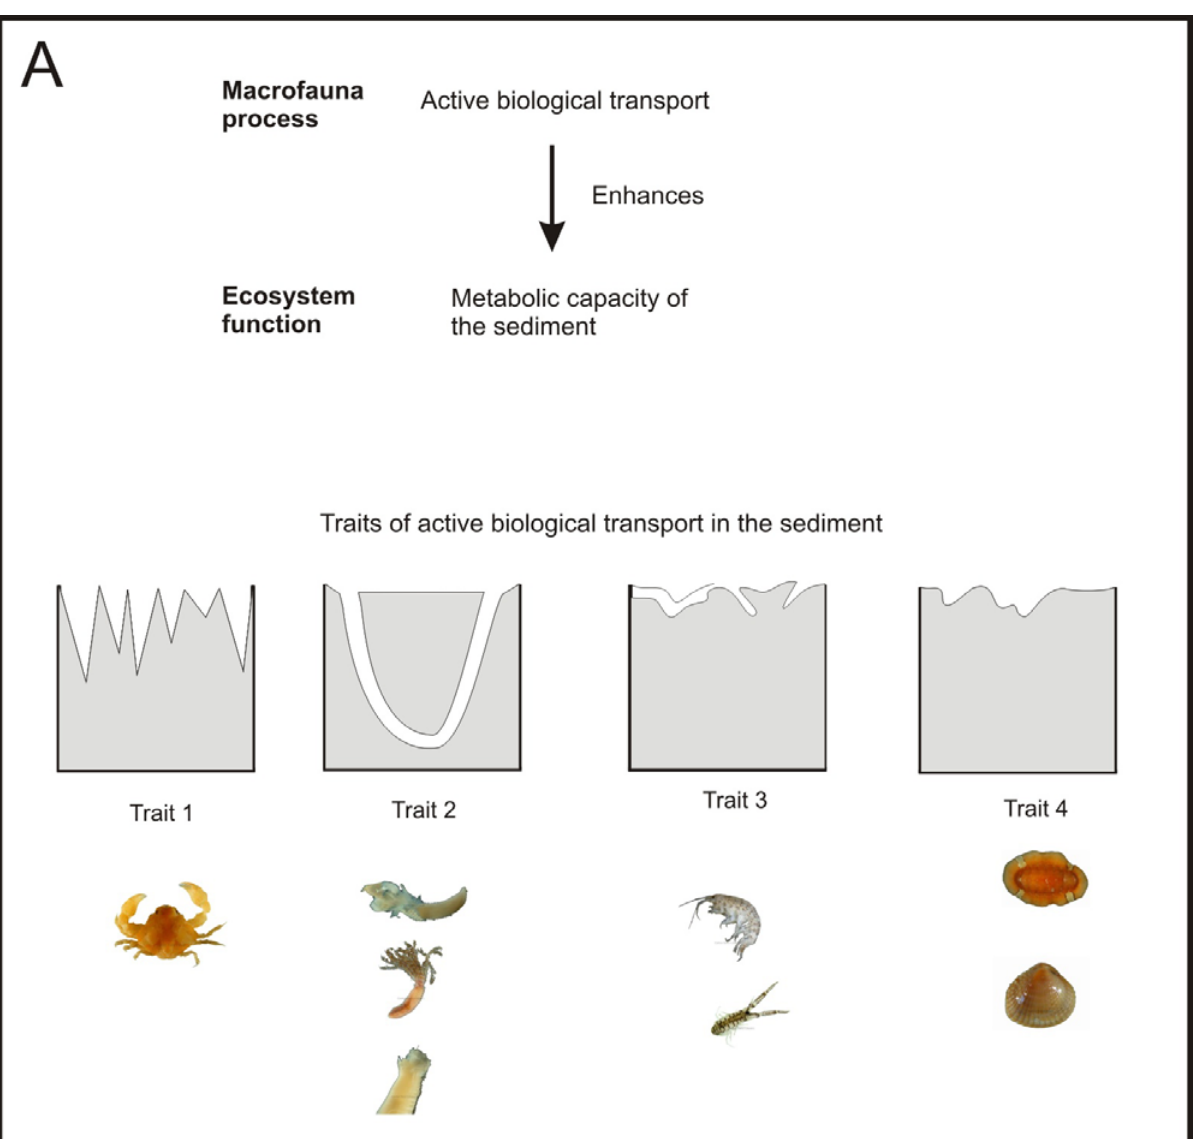
Figure 4. A simplified example of the relative importance that each species could have for a given ecosystem function, and the differential loss of performance of an ecosystem function due to the extinction of different species. (A) This example is based on a macrofauna community composed of eight species which are assigned to different functional groups according to their active biological transport traits. (B) Different traits of active biological transport enhance the metabolic capacity of the sediment to a different extent. Hence, the extinction of different species may affect ecosystem functioning differently according to the type and uniqueness of the trait of the species lost. Note that the loss of species richness, per se , does not necessarily imply a decrease in the performance of a given ecosystem process [123,131]. But, some species may have a disproportionate influence relative to others, and their removal can incur a notable decrease in the performance of that process